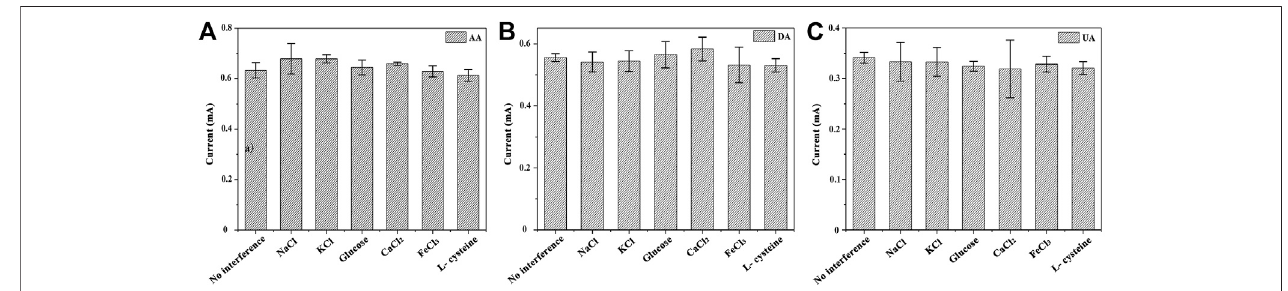
FIGURE7| Testresultsofelectrode anti-interferenceperformanceof7hGNSs/CCelectrodesinPBSbufferwithpH7.4. (A)In fl uenceofinterferingsubstances on AA; (B) In fl uence of interfering substances on DA; (C) In fl uence of interfering substances on UA.